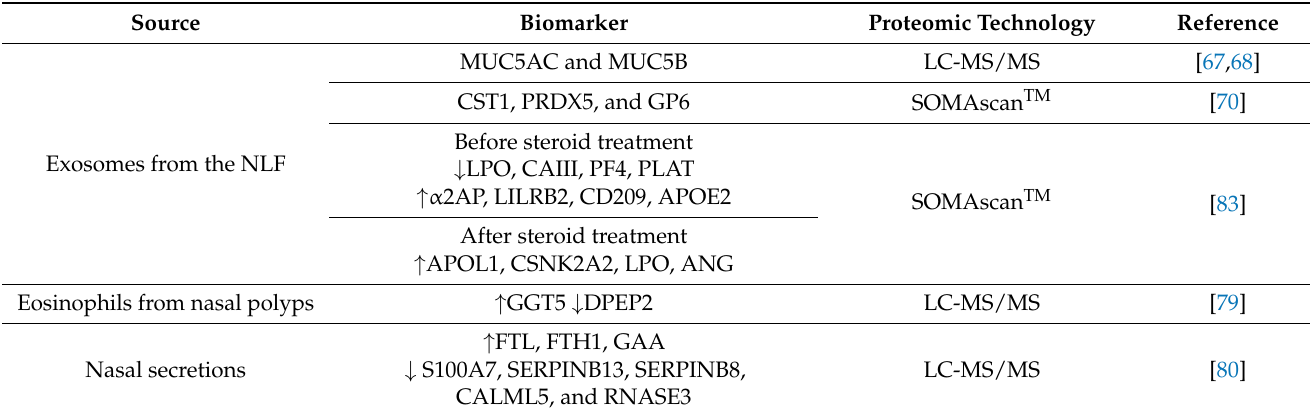
Table 2. Principal proteins found by proteomics involved in Nasal